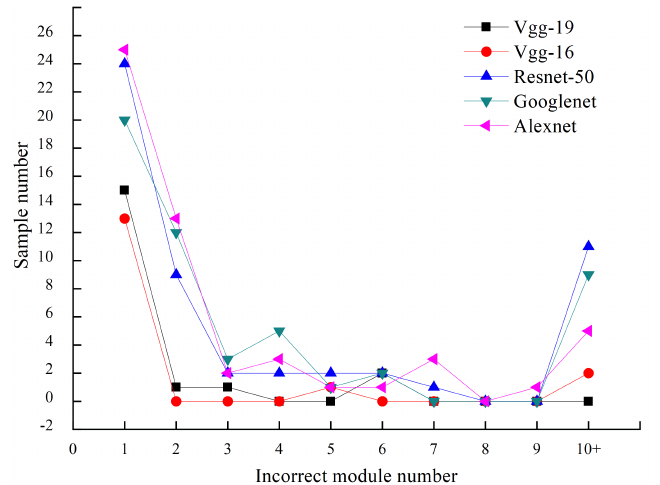
Figure 18. The distribution of incorrect module numbers in barcode reconstruction images with incorrect